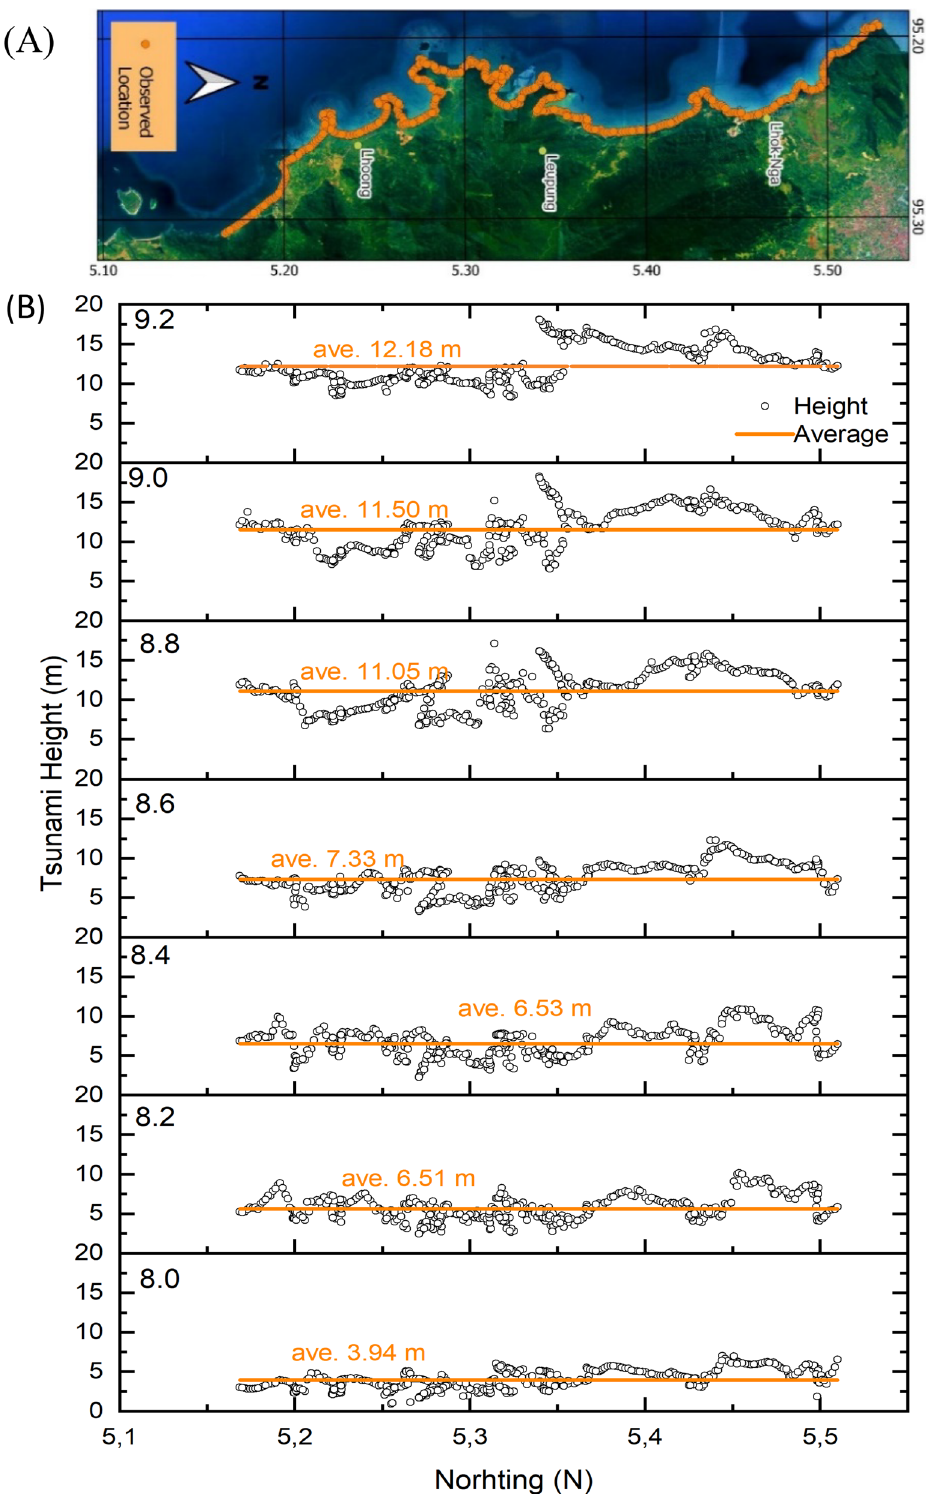
Fig. 8 A Observation points located 50 m from the shoreline (orange colour), B Tsunami height at the observation point for scenarios Mw 8.0 to Mw 9.2 (orange line indicates average tsunami height/flow